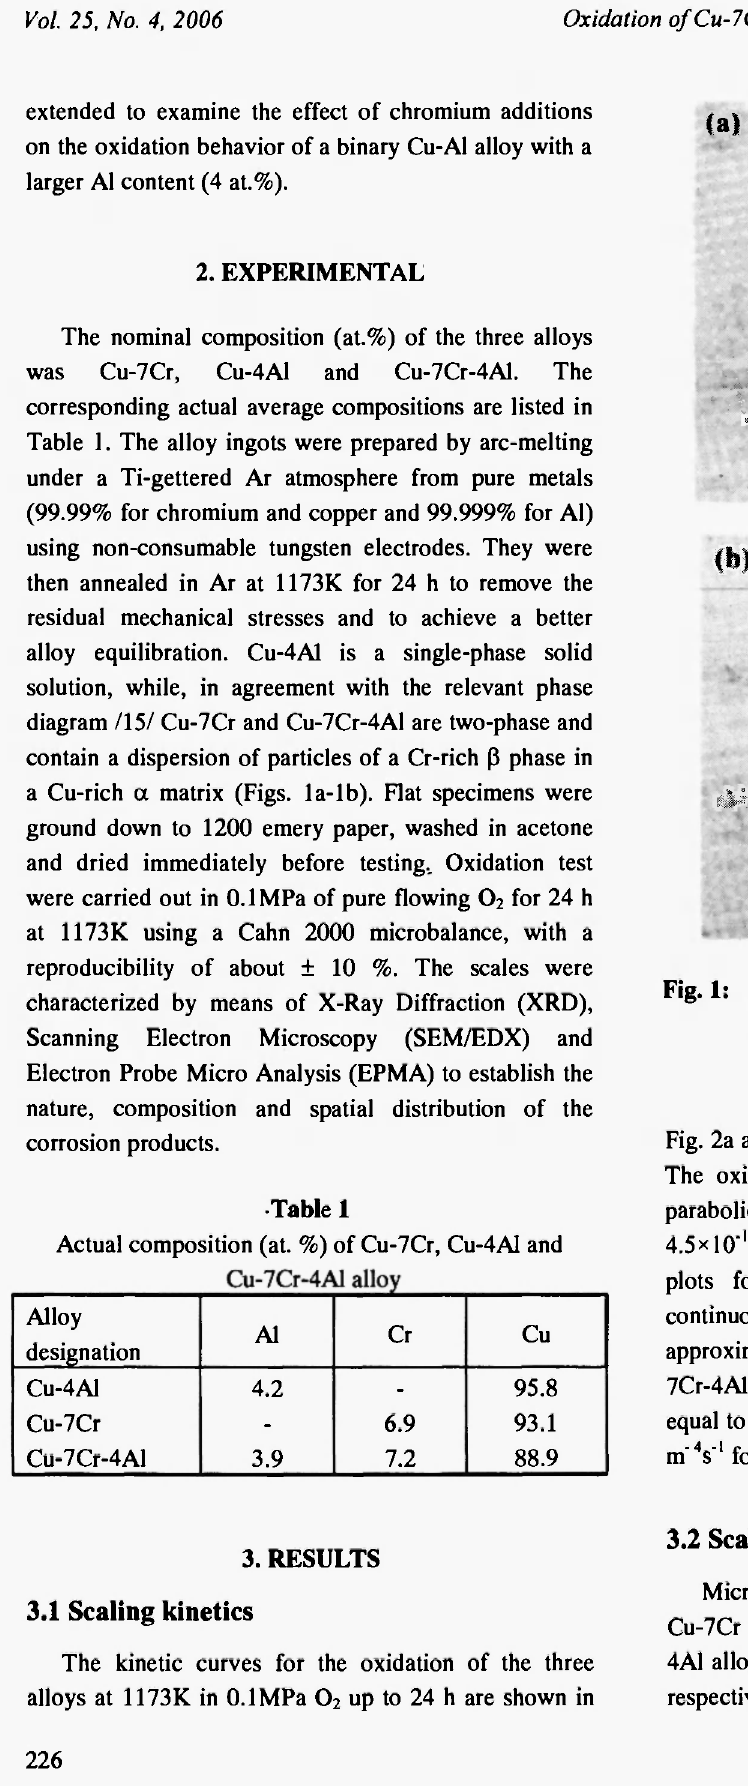
Fig. 1: Microstructure of the alloys Cu-7Cr (a) and Cu-7Cr-4Al (b).